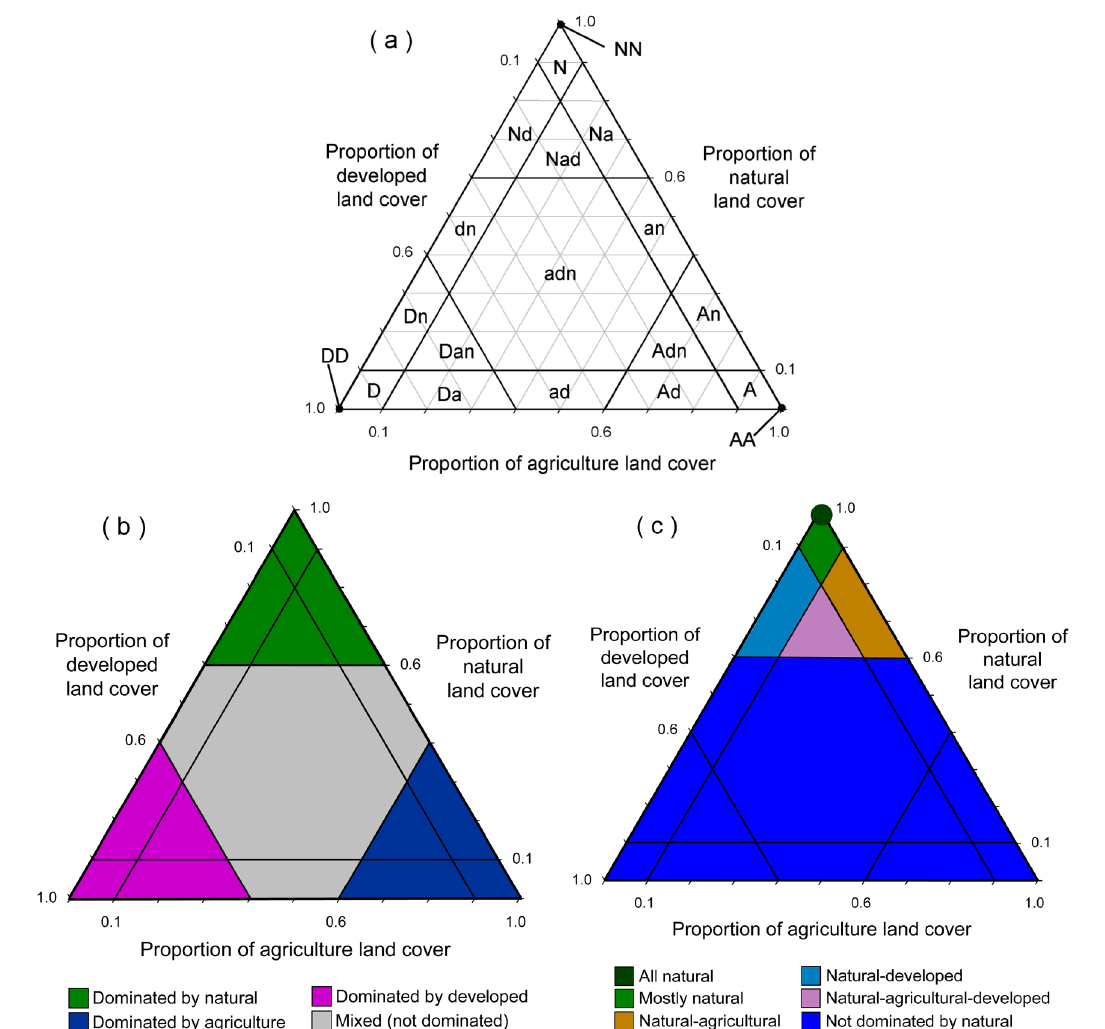
Figure 1: (a) The tri-polar landscape mosaic classification model identifies 19 mosaic classes from the proportions of agriculture, developed, and natural land-cover types in a landscape. The labels shown in the figure are a code that describes the relative amounts of the three land-cover types, as explained in the text. (b) The 19 mosaic classes were condensed into four classes to highlight landscape background. (c) The 19 mosaic classes were condensed into six classes to highlight landscape mosaics within natural